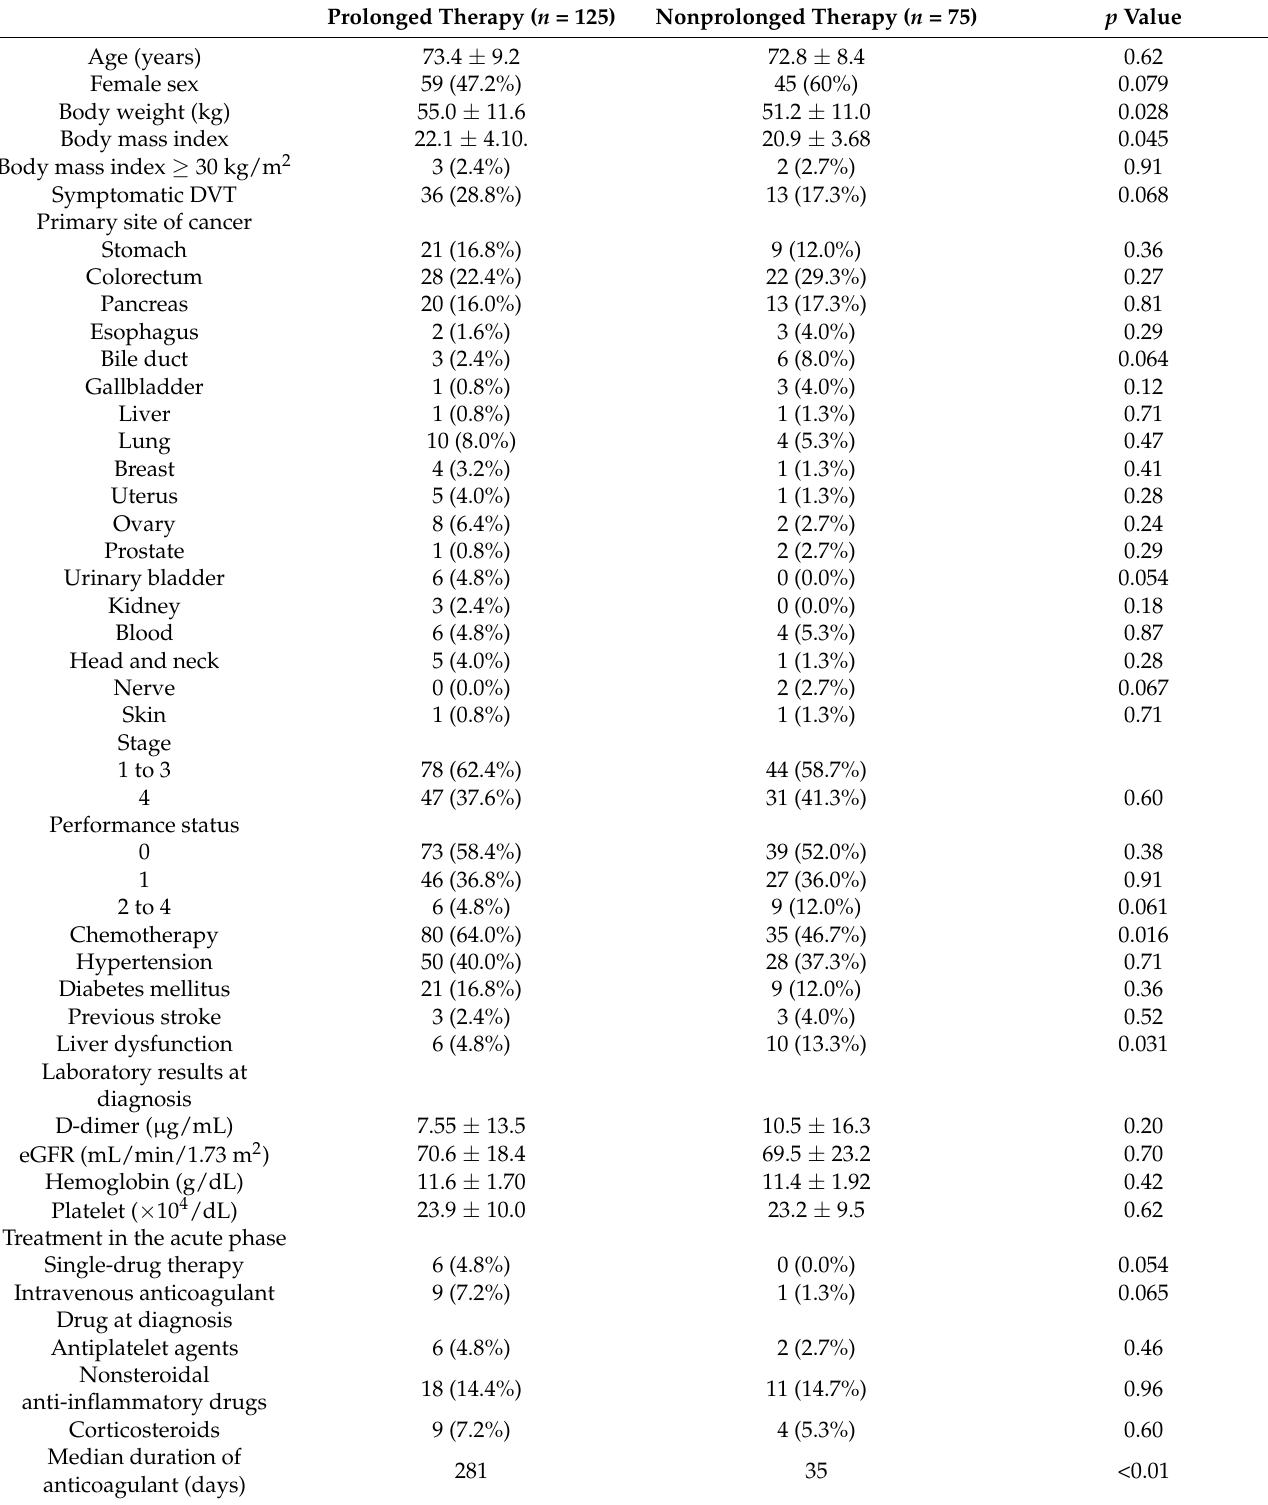
Table 6. Comparison between patients with prolonged and nonprolonged